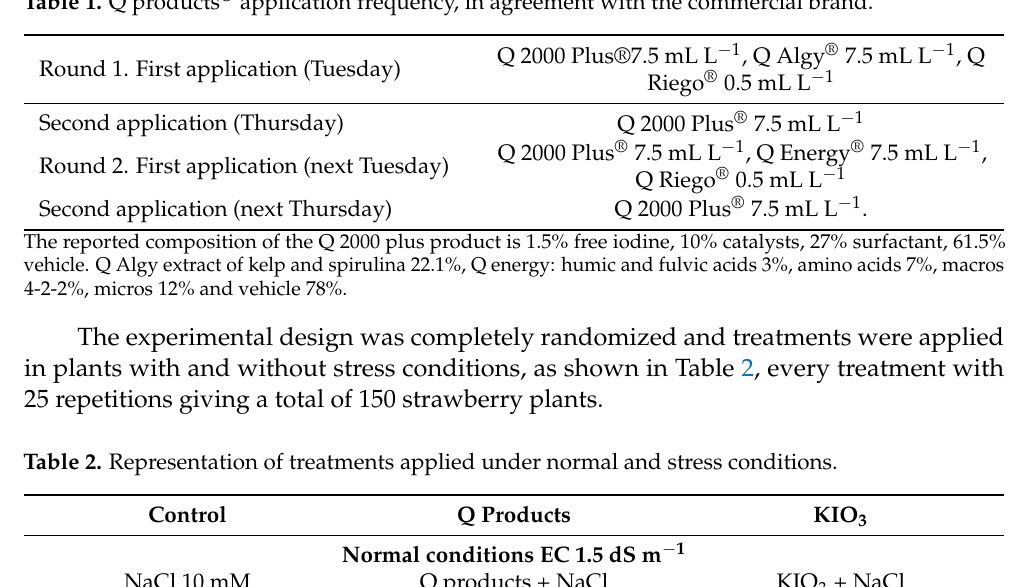
Table 1. Q products ® application frequency, in agreement with the commercial brand.